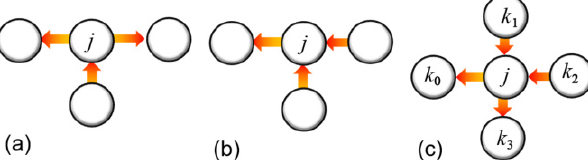
Fig. 5 Crowd flow at an intersection. Simulated agents may split (a) or merge (b) during evacuation. Head-on collision may occur at complex intersections (c). Suppose a crowd of agents attempts to move from k 1 to k 3 and another crowd moves from k 2 to k 0 . Our system assigns agents priorities which are used to choose outgoing edges, to overcome this